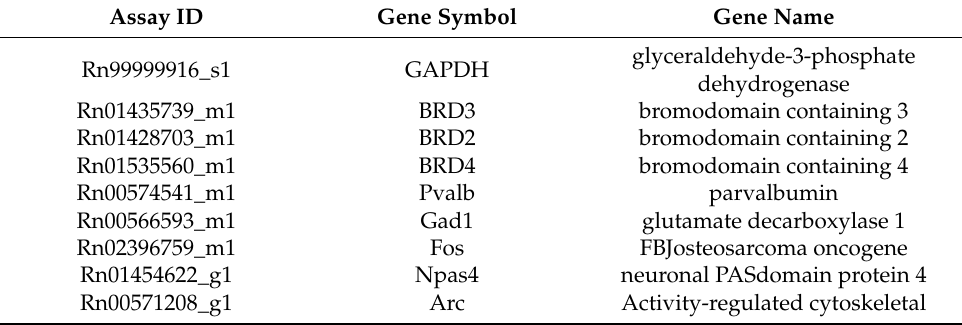
Table 3. A list of a gene-specific primers and